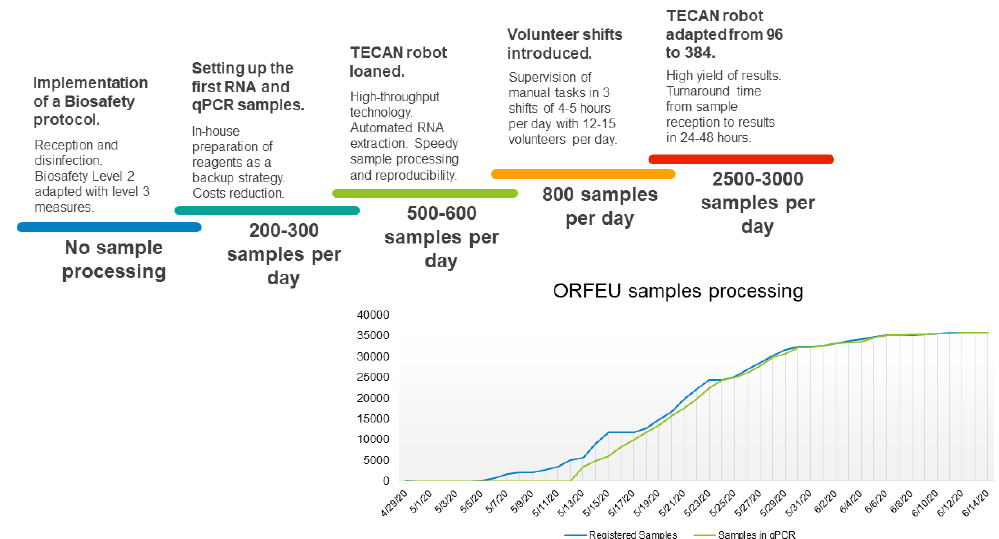
Figure 1. Key milestones towards increasing sampling processing. (Top) Modifications to the workflow, which greatly influenced our ability to handle a larger number of samples. (Bottom) Cumulative number of samples processed from the start to the end of the ORFEU